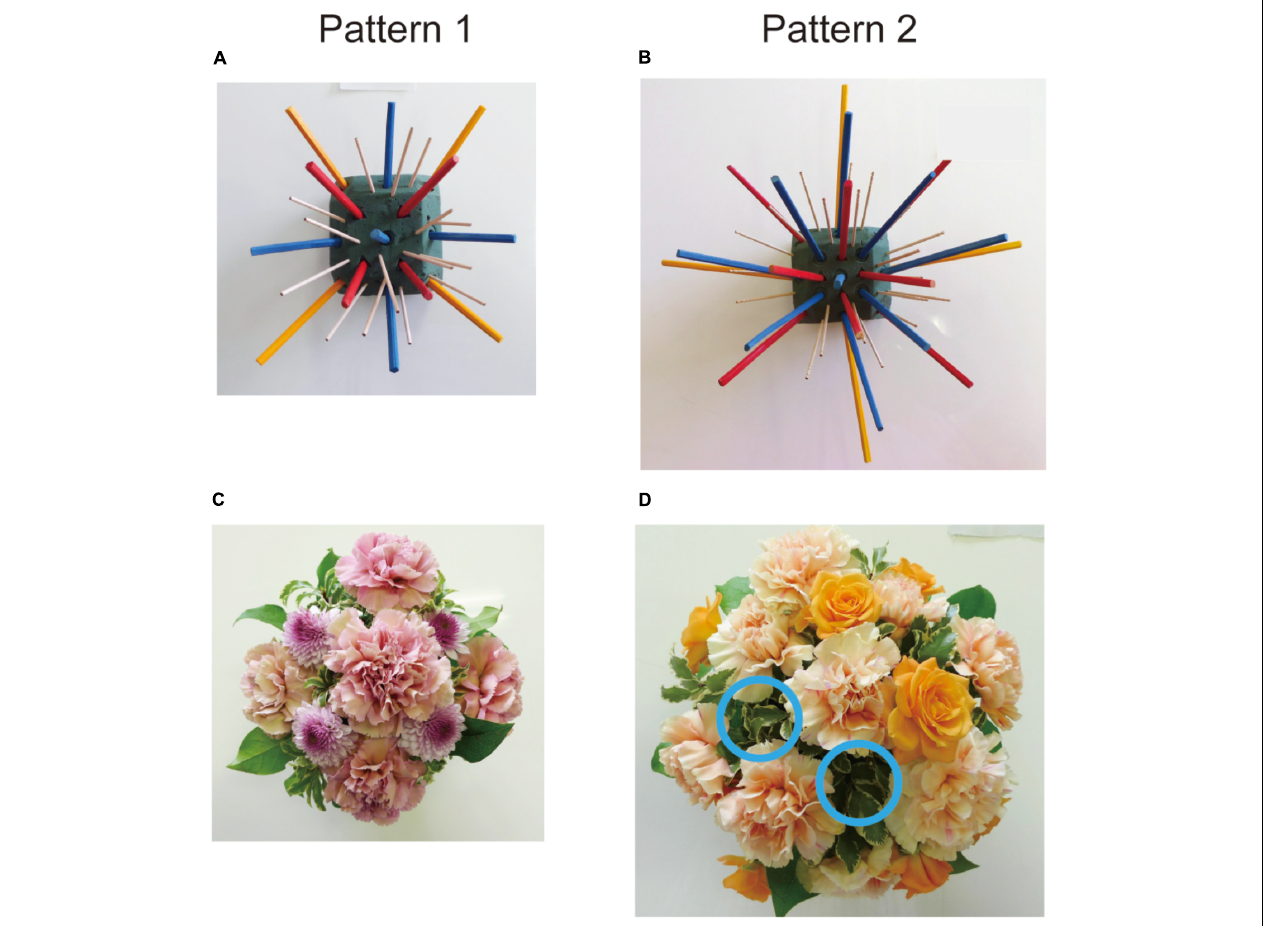
FIGURE 7 | Work samples with sticks (A,B) or flowers (C,D) , arranged by 35-year-old male without assistance in the SFA program. Blue circles indicate lack of orange roses (D) .